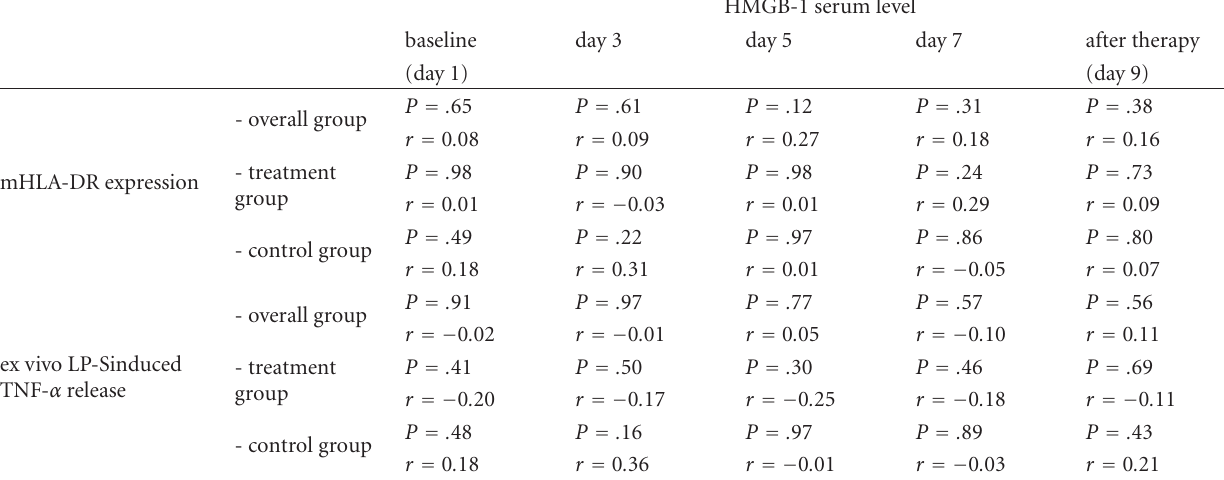
Table 2: Correlation table of systemic HMGB-1 levels with markers of monocytic